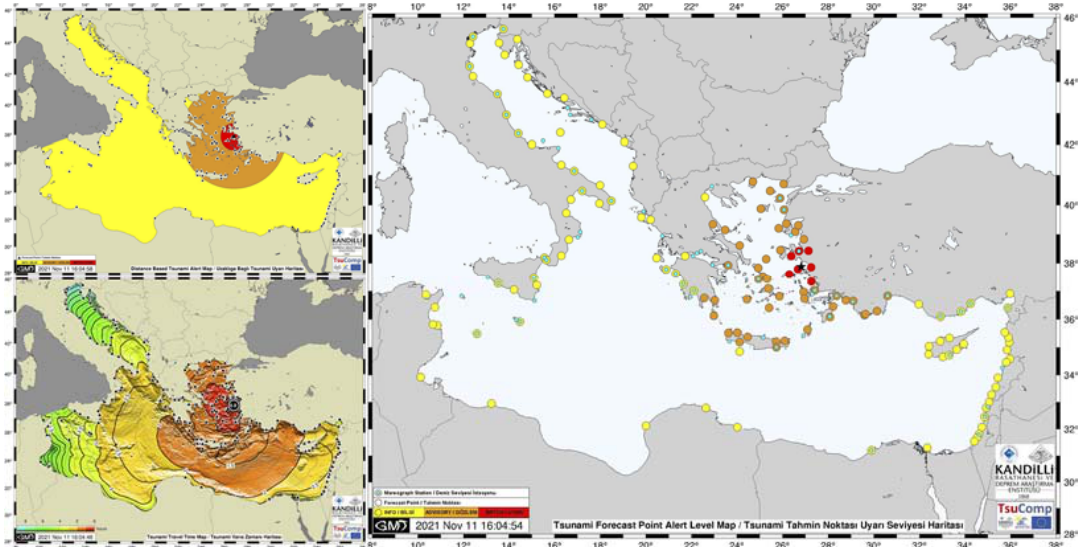
Figure 7. Distance–based tsunami alert map ( top left ), tsunami travel time map ( bottom left ) and tsunami forecast point alert level map ( right ) corresponding to 30 October 2020 Samos earthquake based on Mw 6.9 as the final magnitude calculated for this earthquake by KOERI.